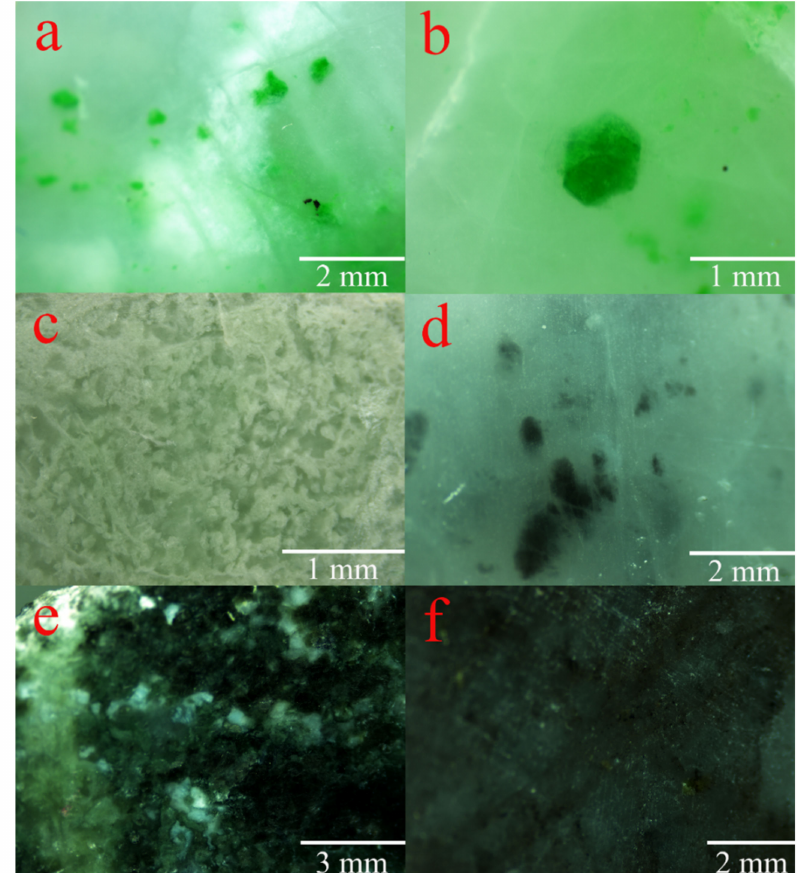
Figure 2. Mineral microstructure of the samples. ( a ) The green spots, green plaques, and black spots in Q-2; ( b ) the green mineral with high euhedral degree in Q-4; ( c ) the cyan-gray sample Q-5 consisting of white and cyan-gray minerals; ( d ) the spot and plaque minerals in the white sample with black spots Q-6; ( e ) image of the “fly wings” reflecting surfaces on the dark green sample Q-7; ( f ) the “waterline” striations on the brown sample